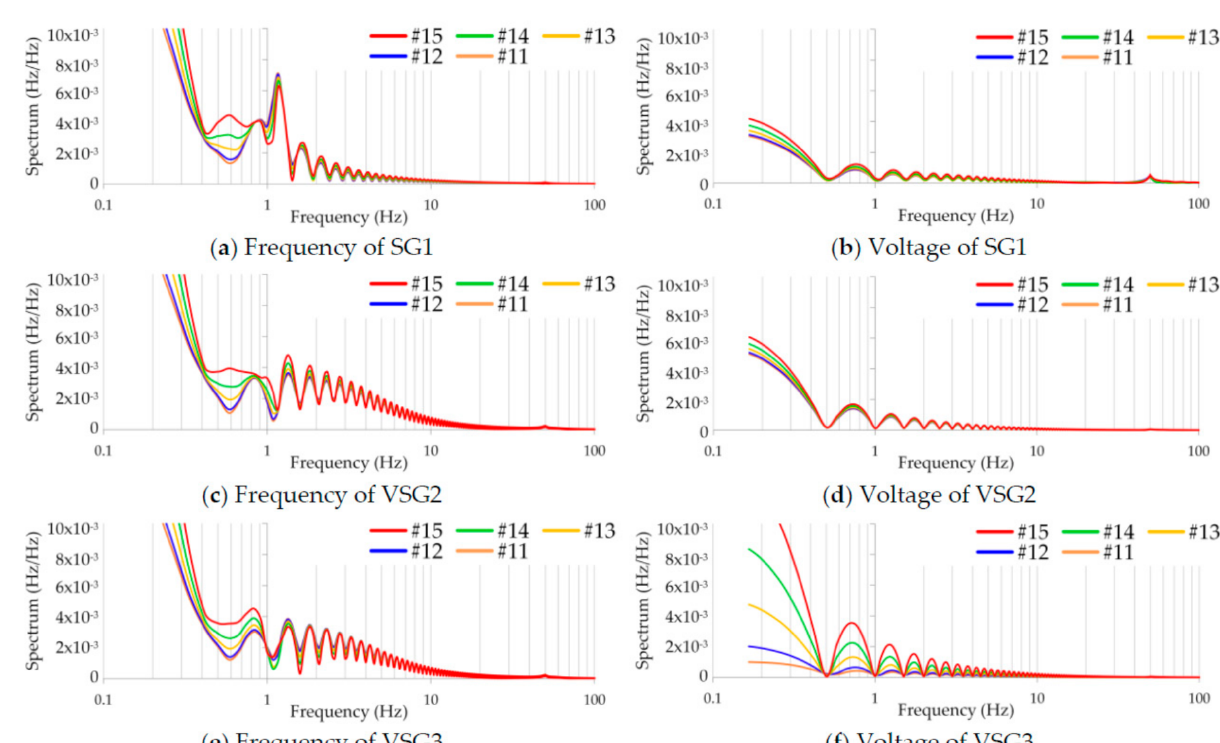
Figure 10. DFT analysis of the system frequency/voltage for tests 11–15 in Table